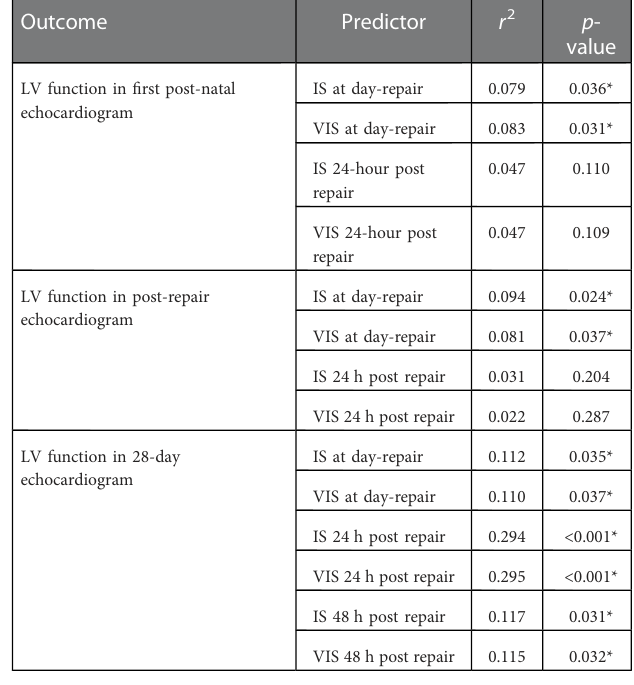
TABLE 4 Associations of iS/VIS obtained following CDH repair (on the day of repair, 24- and 48 hours after repair) with left ventricular function in 1st postnatal, post-repair and 28-day